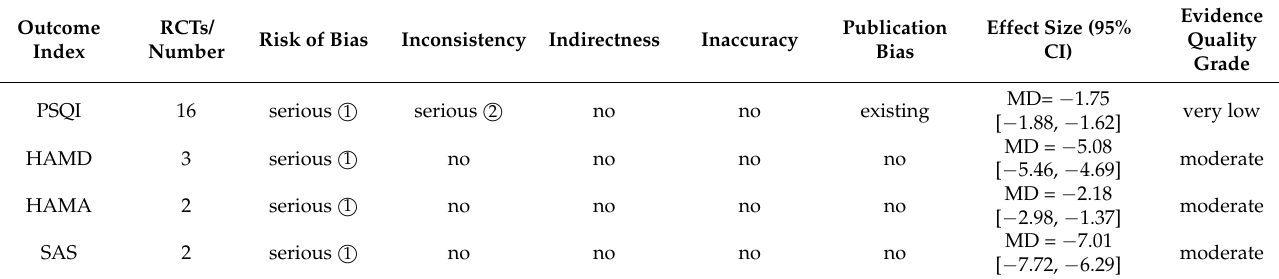
Table 3. Evidence quality rating of outcome indicators.